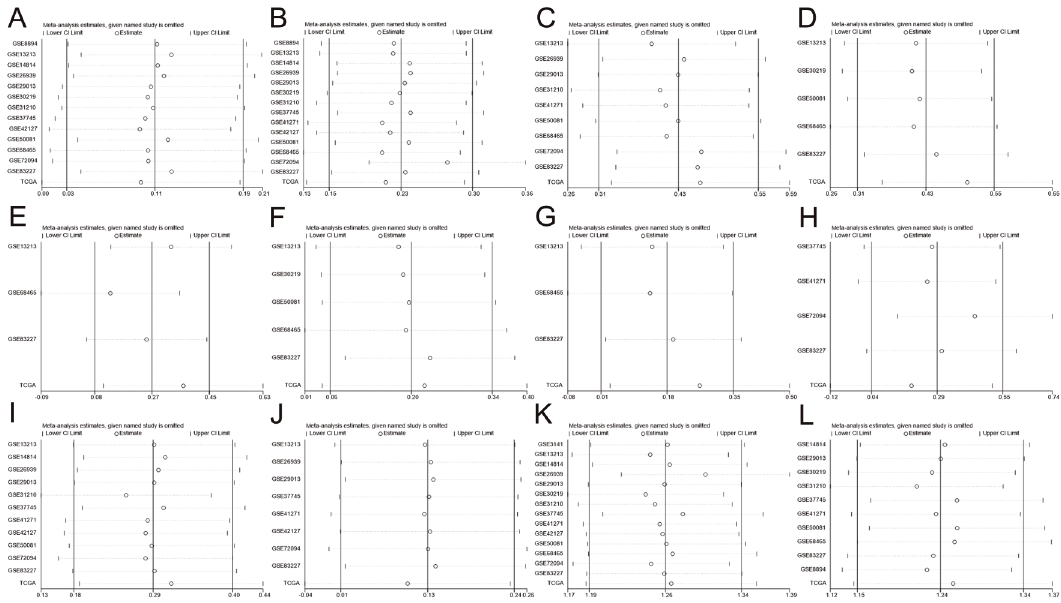
Figure 3 - Sensitivity analyses of patient ( A ) age ( o =65/ 4 65), ( B ) sex (male/female), ( C ) smoking status (yes/no), ( D ) T stage (T2/T1), ( E ) T stage (T3-T4/T1-T2), ( F ) N stage (N1/N0), ( G ) N stage (N2-N3/N0-N1), ( H ) M stage (M1/M0), ( I ) AJCC stage (stage II/stage I), ( J ) AJCC stage (stage III-IV/stage I-II), ( K ) OS, and ( L )